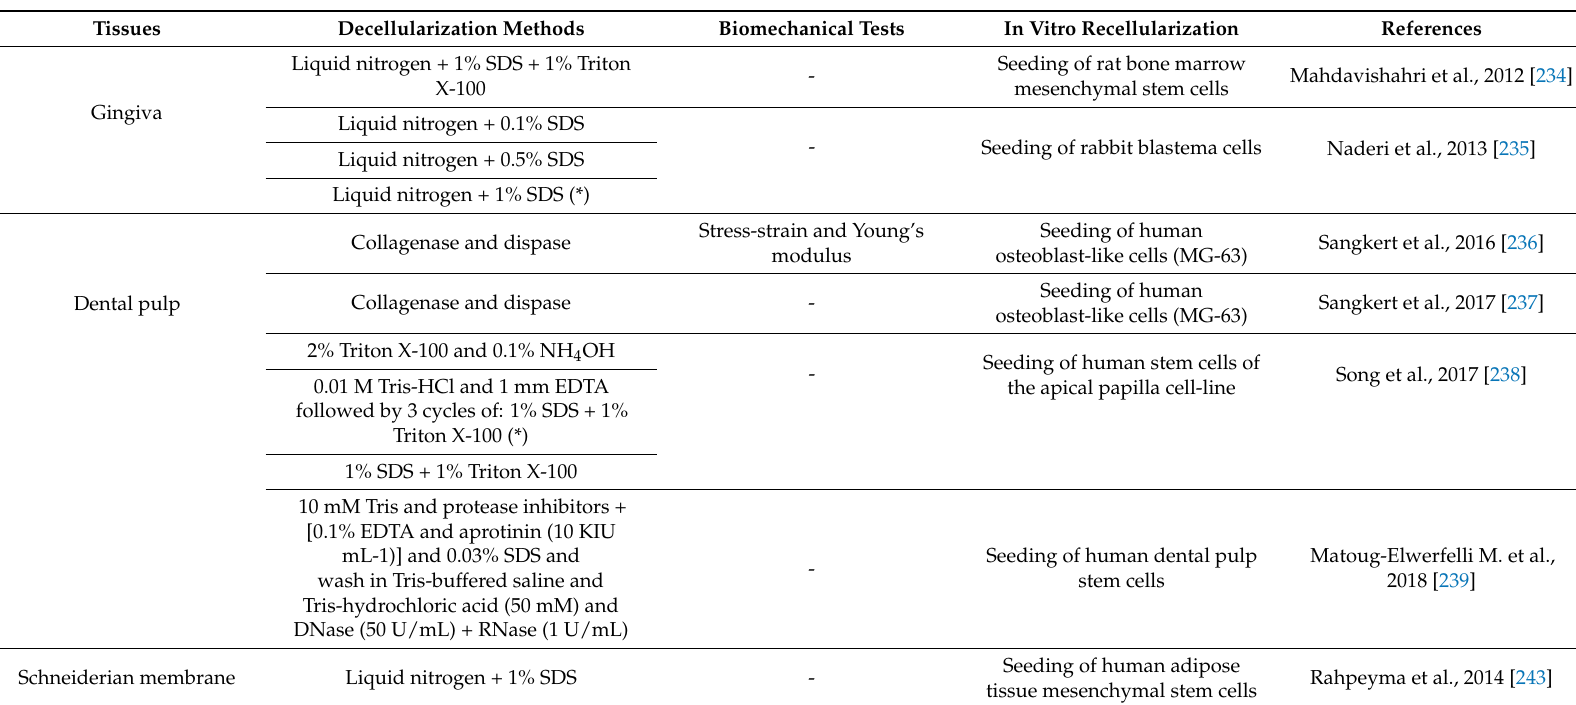
Table 6. Buccal cavity. Decellularization techniques, biomechanical tests, and recellularization methods of human buccal cavity extracellular